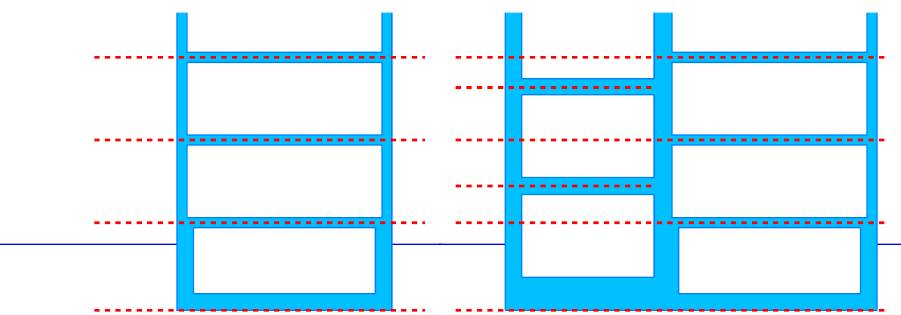
Figure 7. Restrictions on the maximum building height and the maximum number of stories are closely related; however, the associated rules correspond only in simple cases ( left ). In more com- plicated cases, the rules on the number of floors and the maximum height are independent of each other ( right